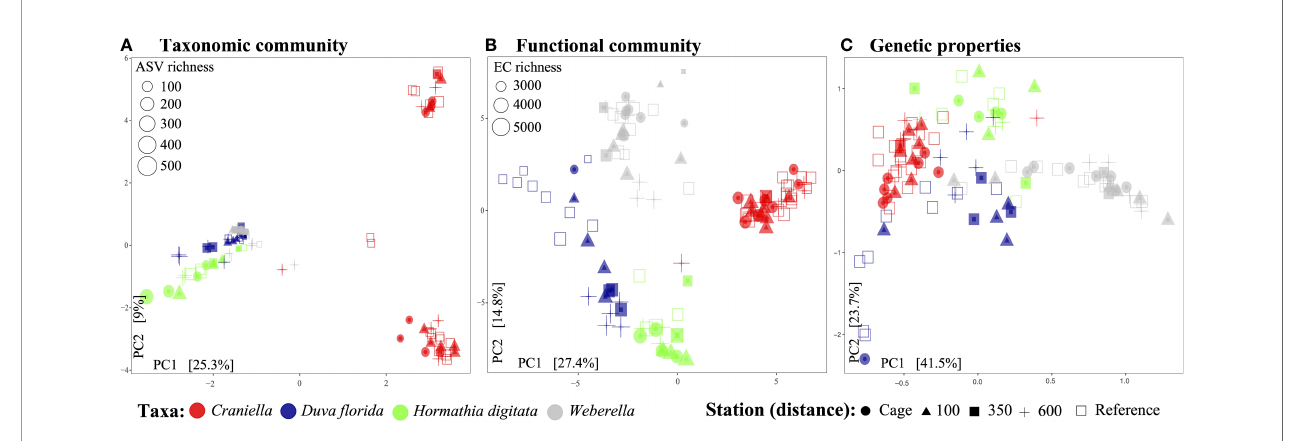
FIGURE 7 | Principal components analysis of the epibenthic taxa ’ bacterial taxonomic (A) and functional (B) diversity, and microbiome genetic properties (C)